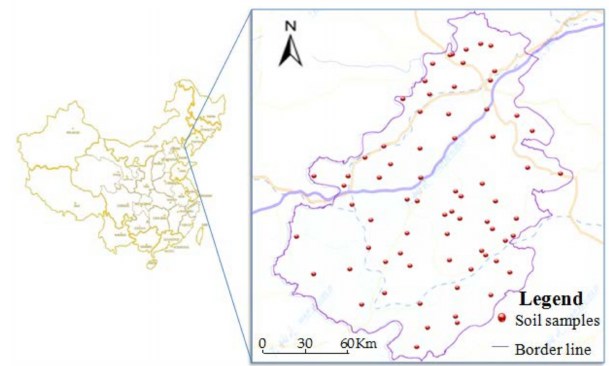
Figure 1. Distribution of soil sampling sites in the study